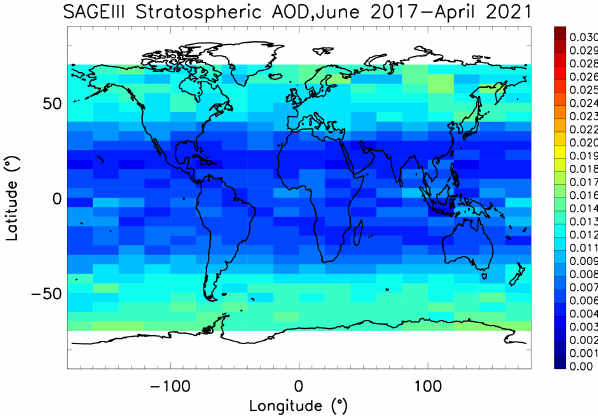
Figure 3. Stratospheric AOD (532nm) climatology from SAGE-III for the period June 2017–April